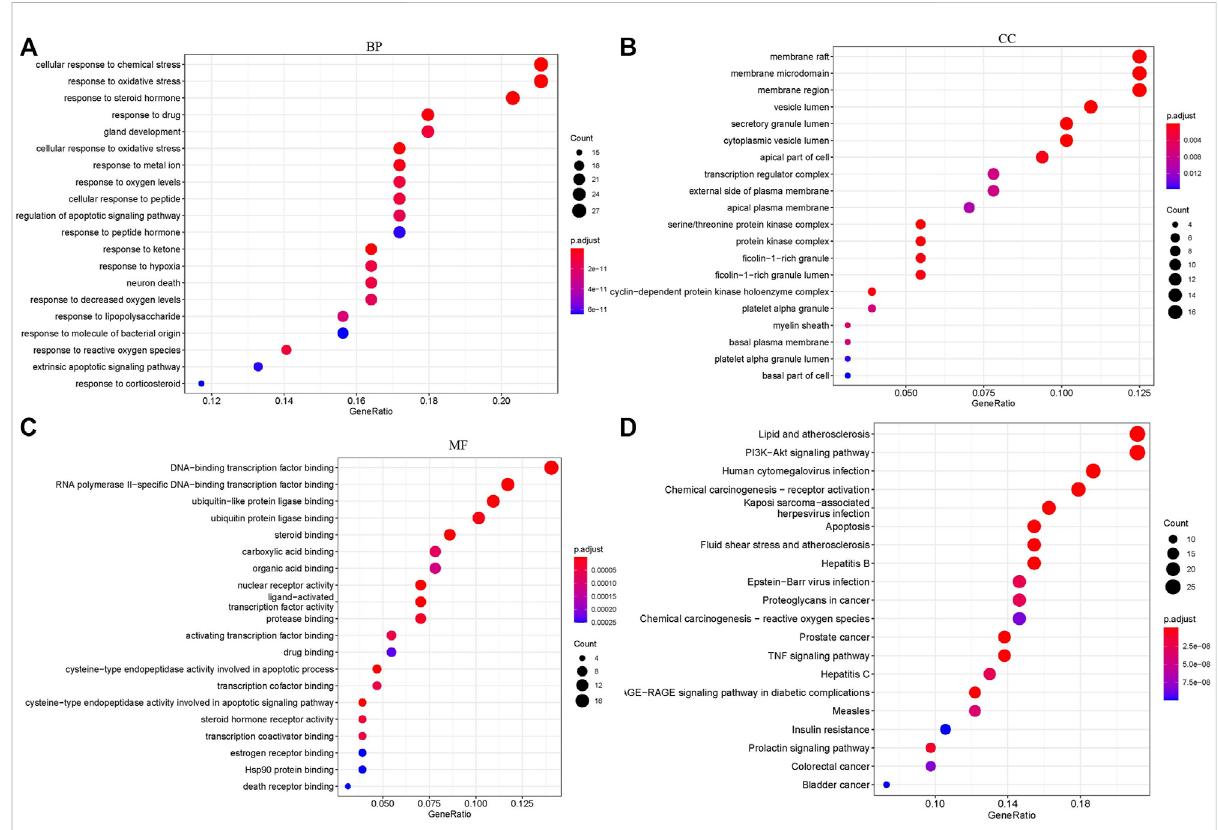
FIGURE 3 Target biological function analysis: GO and KEGG analysis. (A) BP analysis of 129 FZHY – CKD target genes. (B) CC analysis of 129 FZHY – CKD target genes. (C) MF analysis of 129 FZHY – CKD target genes. (D) KEGG pathway enrichment analysis of 129 FZHY – CKD target genes. KEGG, Kyoto Encyclopedia of Genes and Genomes; BP, biological process; MF, molecular function; CC, cellular